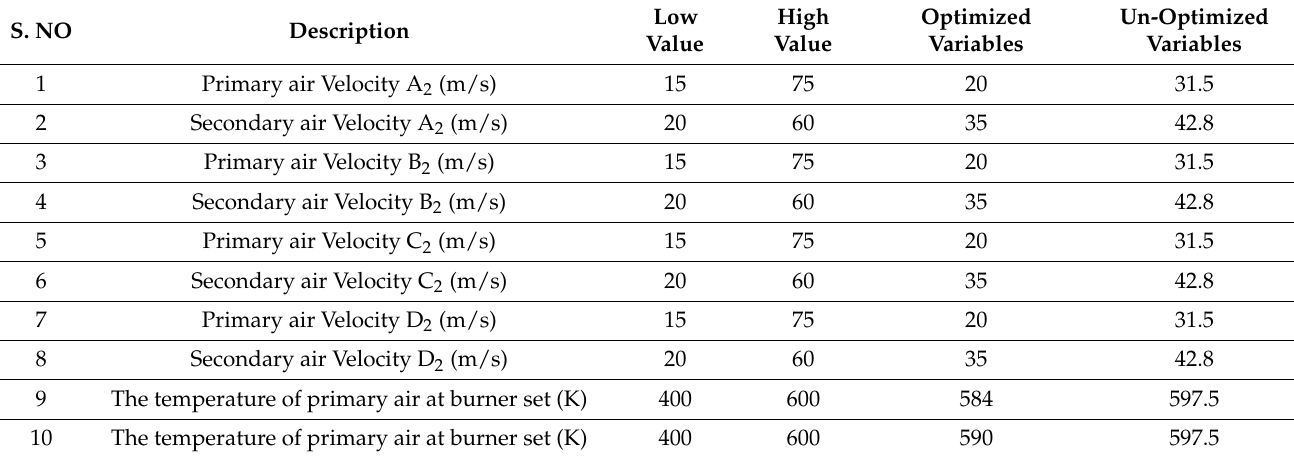
Table 10. Decision variables of optimized and un-optimized.